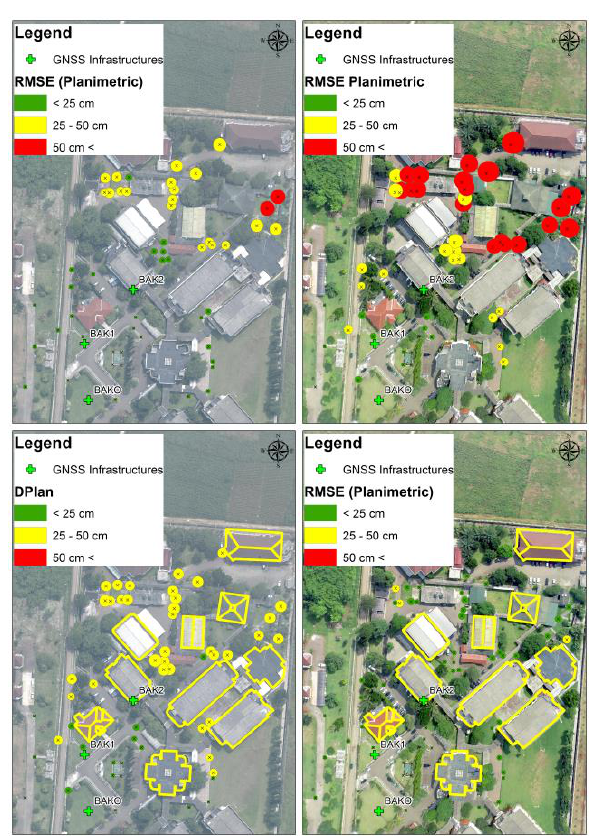
Figure 8. Accuracy Assessment: DG Trimble Phase One (upper-left), Combined Canon S-100 (upper-right), Combined (10 Buildings) Trimble Phase One (lower-left) and Combined (10 buildings) Canon S-100 (lower-right) Combining the direct georeferencing (GPS/INS data) and indirect georefencing (8 GCPs) the empirical deviation from